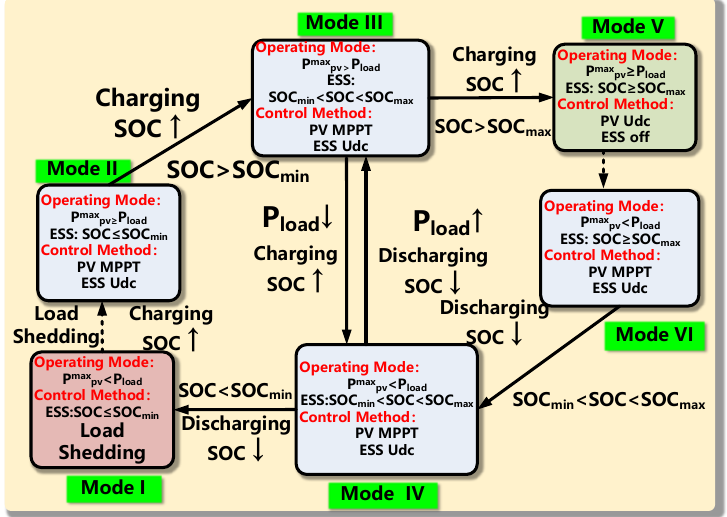
Figure 3. Operation modes of an off-grid DC microgrid.